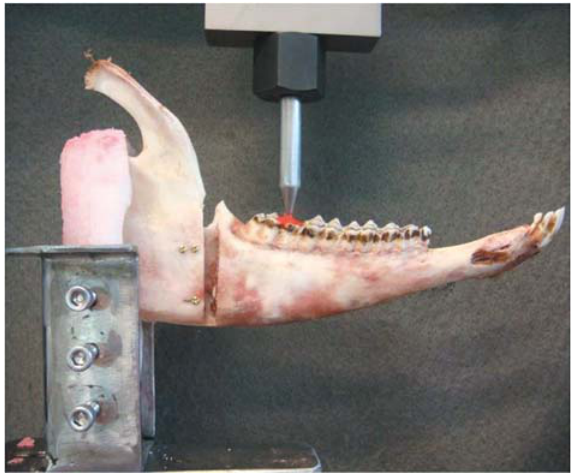
Figure 6- (cid:2)(cid:3)(cid:4)(cid:5)(cid:6)(cid:7)(cid:8)(cid:9)(cid:10)(cid:2)(cid:11)(cid:12)(cid:10)(cid:6)(cid:2)(cid:13)(cid:14)(cid:2)(cid:13)(cid:15)(cid:10)(cid:2)(cid:16)(cid:17)(cid:18)(cid:18)(cid:14)(cid:19)(cid:13)(cid:2)(cid:4)(cid:5)(cid:6)(cid:2)(cid:18)(cid:14)(cid:16)(cid:7)(cid:13)(cid:7)(cid:14)(cid:5)(cid:10)(cid:6)(cid:2)(cid:7)(cid:5)(cid:2) the KRATOS K2000MP universal testing machine